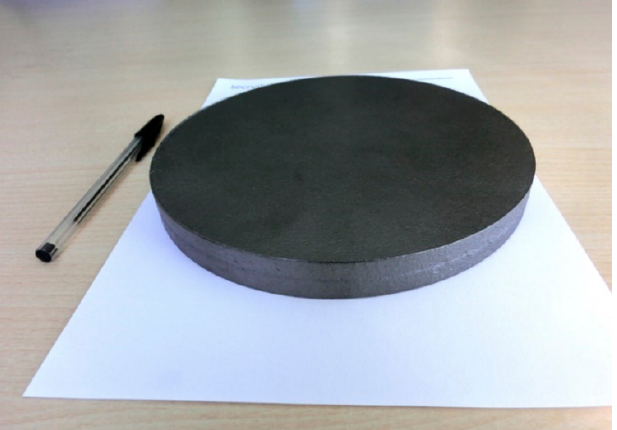
Figure 16. Ti composite part of large dimensions (20 cm in diameter), elaborated by SPS [95]. Reproduced with permission from Materials Science and Engineering: A , published by Elsevier, 2016.